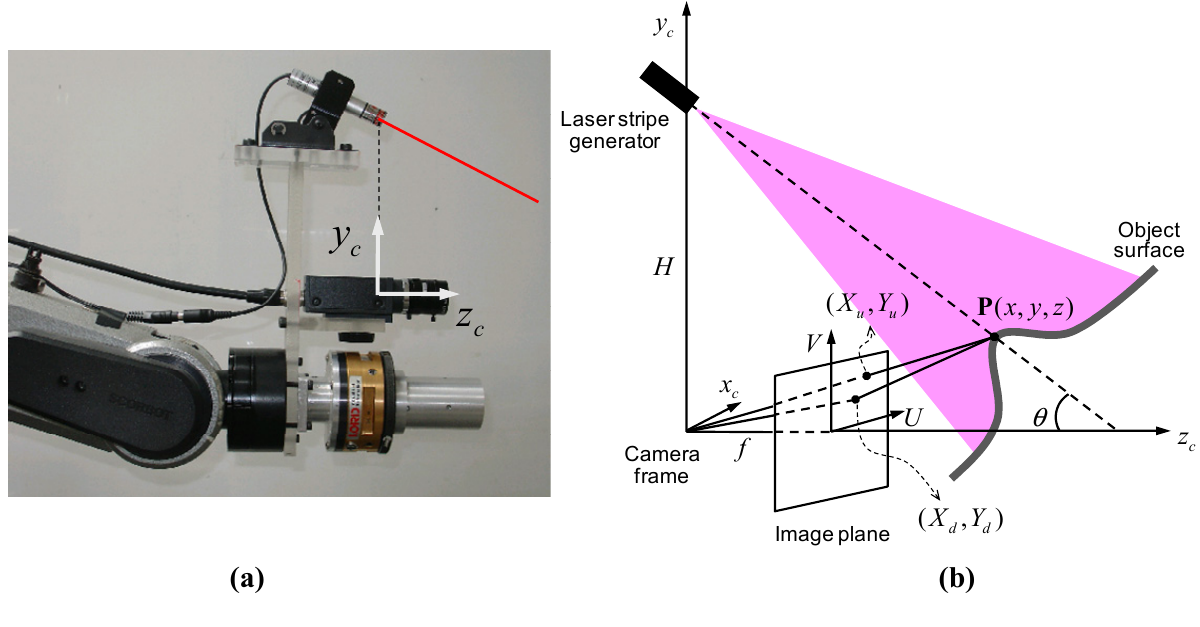
Figure 1. The laser-vision sensor model. The laser-vision sensor consists of a camera and a laser stripe generator. A 3D range data is obtained by using both the camera projection model and the optical triangulation principle. ( a ) Laser-vision sensor. ( b ) Laser-vision sensor